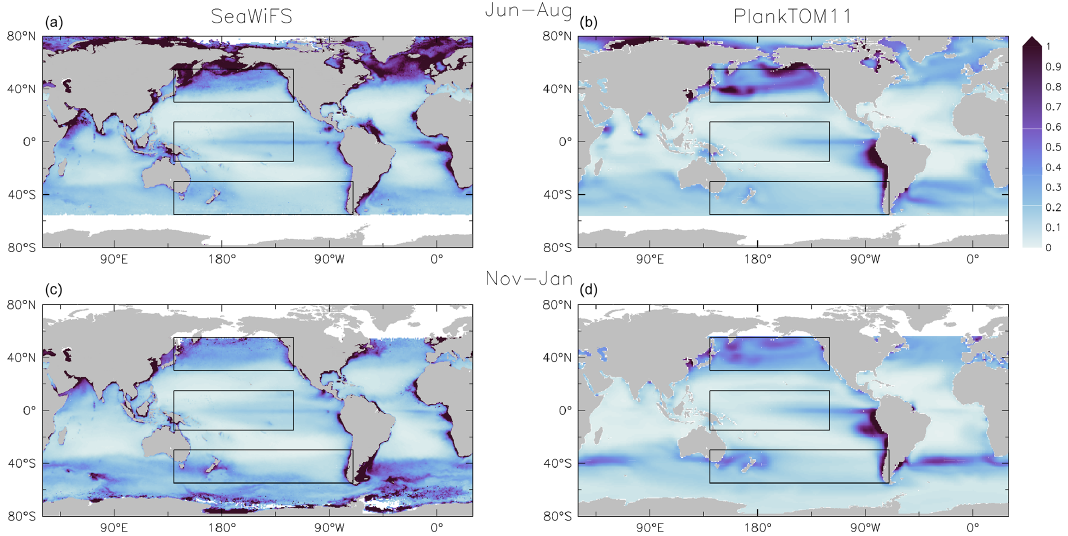
Figure 8. Surface chlorophyll (µgchlL − 1 ) averaged for June to August (a, b) and November to January (c, d) . Panels show observations from the SeaWiFS (a, c) satellite and results from PlankTOM11 (b, d) . Observations and model are averaged for 1997–2006. The black boxes show the Pacific northern, tropical and southern regions used in Figs. 4 and